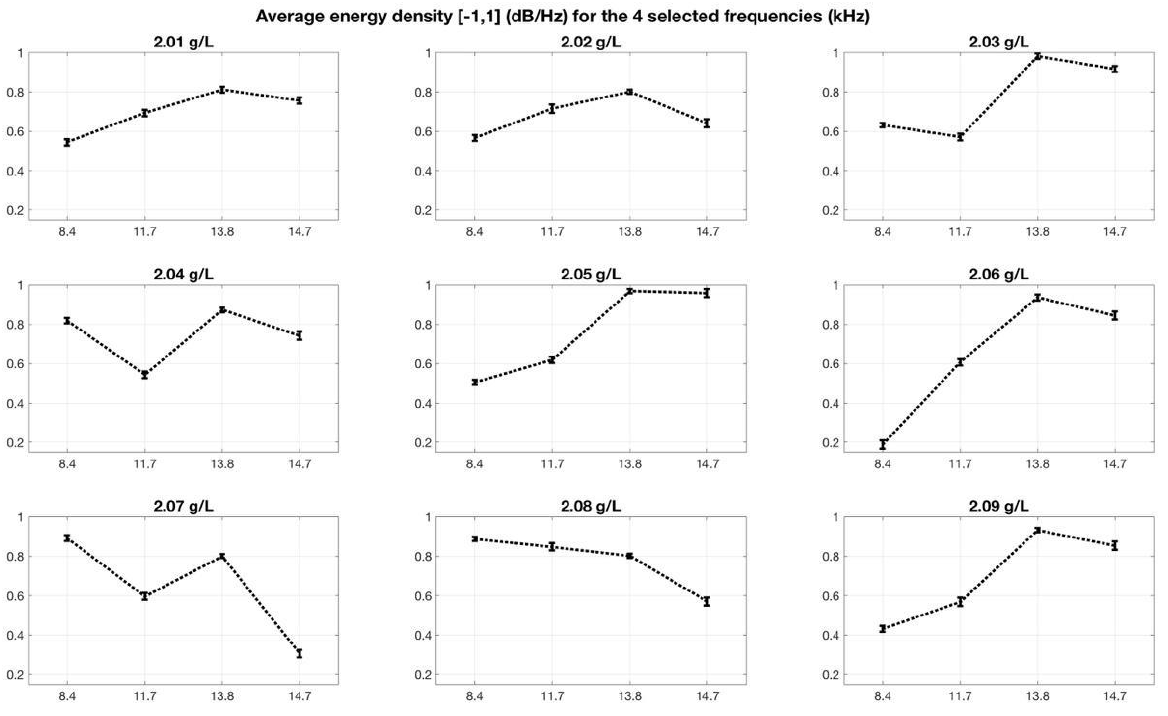
Figure 9. Spectral information patterns for fructose concentrations from 2.01 g/L to 2.09, with the average and normalized value of the sound pressure level (dB/Hz) as a function of the frequencies (kHz) used by the classifier 1.